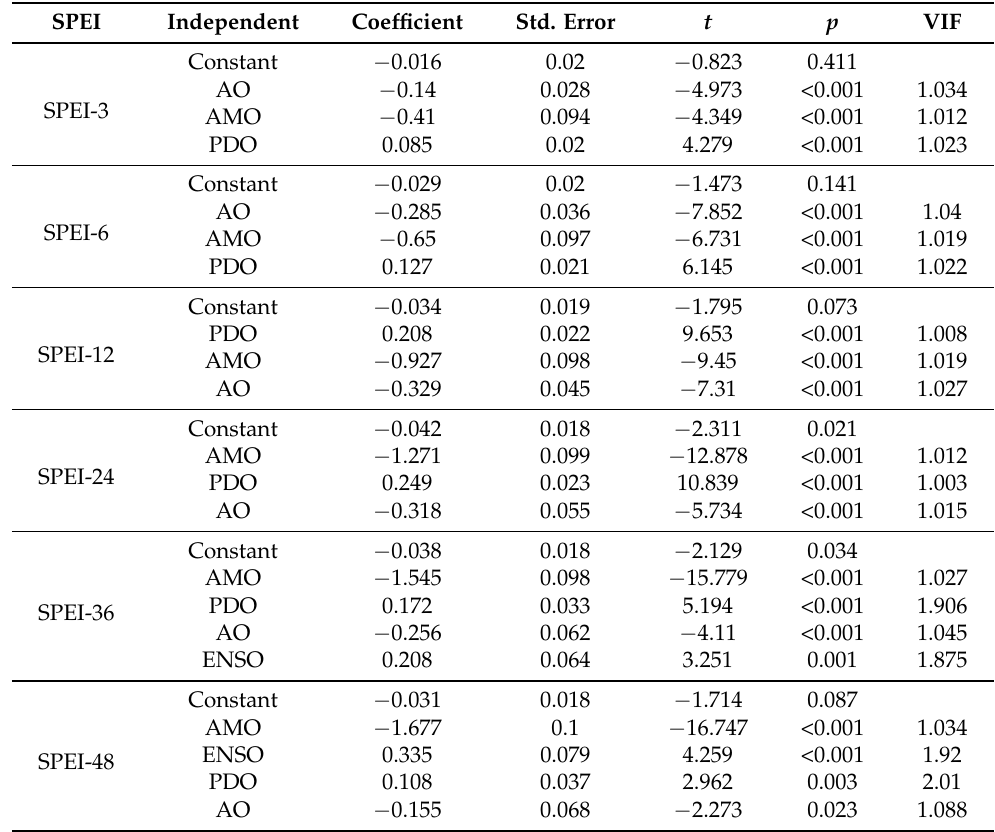
Table 1. Test statistics of stepwise regression for SPEI-3, SPEI-6, SPEI-12, SPEI-24, SPEI-36, and SPEI- 48 based on ENSO(NINO3.4), PDO, AMO, and AO indices. The significance of the t -test statistics is evaluated at 95% confidence interval. Two-tailed t -test statistics is applied, hence the computed p -value less than 0.025 indicates the significance of relationship between the SPEI and teleconnections. The higher Variance Inflation Factor (VIF) refers to the stronger the multi-collinearity